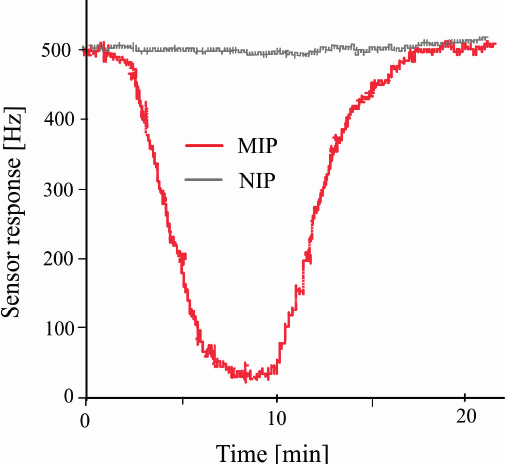
Figure 4. Sensor responses of estradiol imprinted polyurethane against its templated analyte (estradiol). Non-imprinted polyurethane layer served as reference for differential